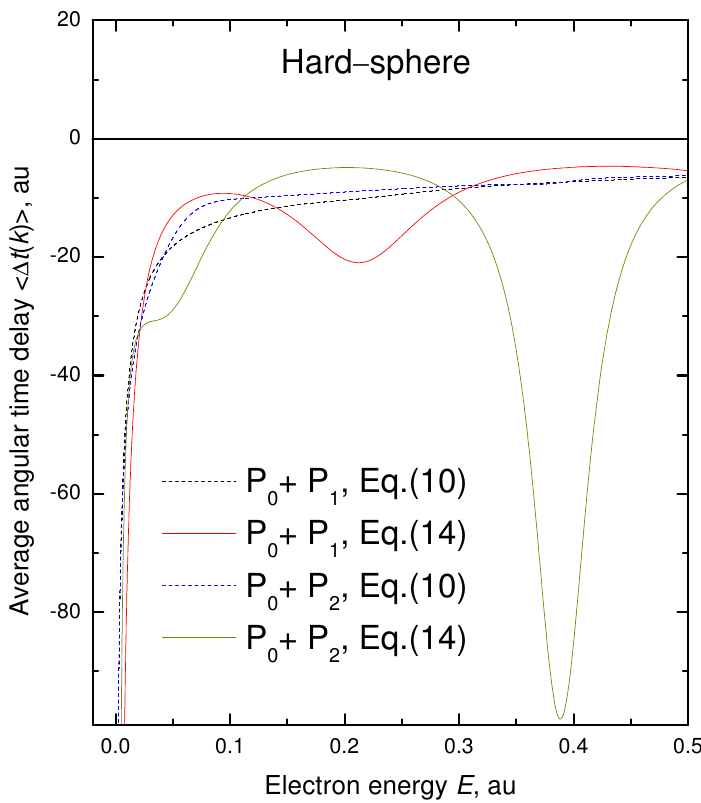
Figure 4. The function (14) in the case of electrons scattered by the hard-sphere target. P 0 + P 1 and P 0 + P 2 are the pairs of Legendre polynomials P l ( cos θ ) . Note that Equation (10) corresponds to Formula (10) in